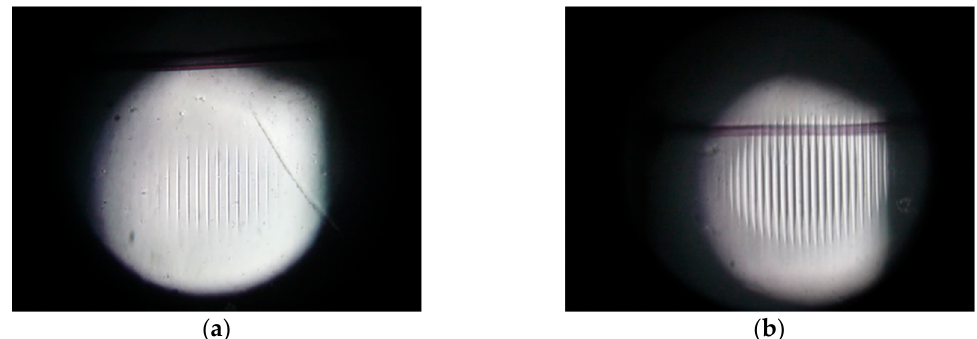
Figure 14. Photographs showing two fabricated gratings with exposure times of ( a ) 90 ms and ( b ) 140 ms. The distance between fringes is 263 µm.